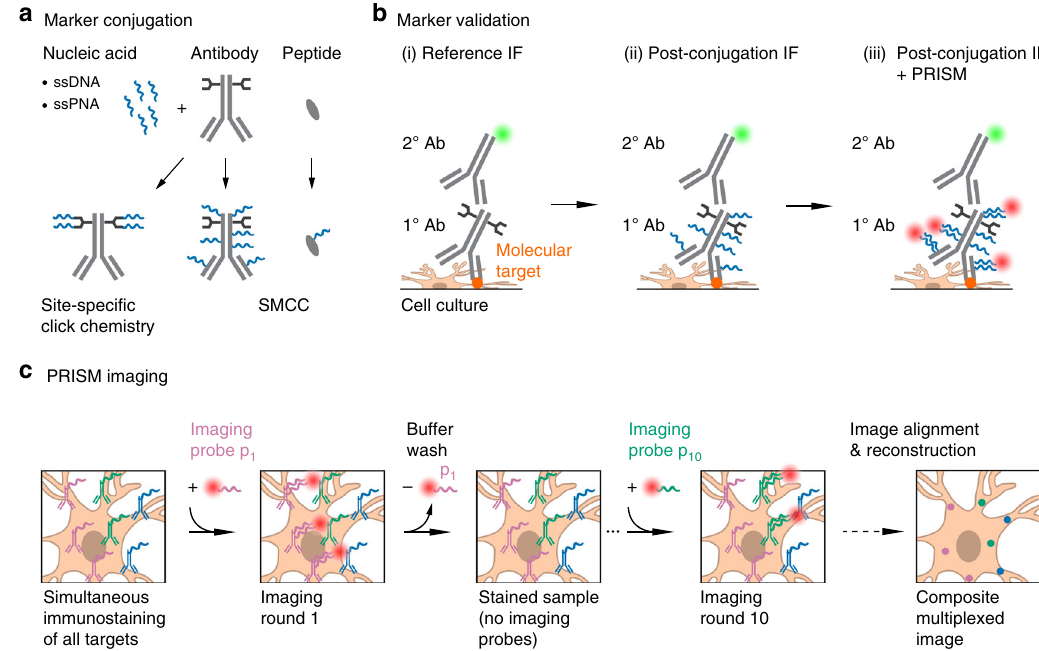
Fig. 1 Schematic of the PRISM imaging technique. a Reagents (markers, shown in gray) for detecting subcellular targets include antibodies or peptides that are conjugated with unique oligonucleotide barcodes (docking strands, shown in blue). A barcoded marker is imaged using the complementary fl uorophore-conjugated oligonucleotides (imaging probes) that bind to the docking strands on the marker (see (iii) in b , fl uorophores shown as red circles). Binding af fi nity of the imaging probes to the docking strands can be varied by changing the sequence and type of the oligonucleotides, which thereby enables either diffraction-limited (high af fi nity) or super-resolution microscopy (low af fi nity). Conjugation of docking strands to markers using site-speci fi c click chemistry enables stoichiometric control of the number of nucleic acids bound to a whole antibody, while SMCC enables conjugation of docking strands to free amine groups on a variety of markers. b The reagent testing and validation phase consists of (i) generation of reference staining patterns of all molecular targets of interest using standard immuno fl uorescence (IF), (ii) analysis of the speci fi city and staining quality of markers conjugated with docking strands compared to those in the reference IF, and (iii) co-localization of PRISM-imaged staining patterns using imaging probes (red circles, which correspond to fl uorophores conjugated to the probes) with standard IF staining patterns (green circles). c Overview of the main steps in the PRISM imaging work fl ow. All molecular targets of interest are immunostained at once using docking strand-conjugated markers (e.g., antibodies shown in green, blue, and pink). Nucleic acid imaging probes speci fi c to each marker (e.g., p 1 – p 10 ) are applied and imaged sequentially, with each imaging strand washed out after image acquisition at each step. This approach enables imaging a dozen or more distinct molecular targets in the same sample. Images of different markers are drift-corrected and overlaid to generate a pseudo-colored, multiplexed image. For super-resolution PRISM, prior to drift correction, the super-resolved image of each marker is reconstructed from the temporal image stack of binding/unbinding events of the imaging probes to/from the docking strands on the